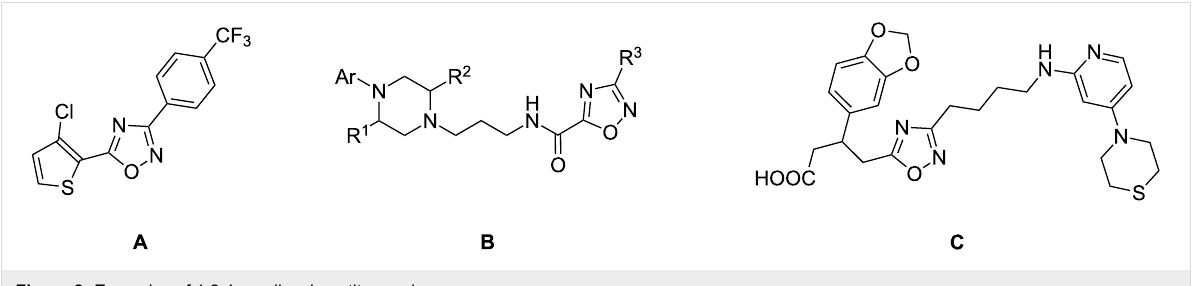
Figure 2: Examples of 1,2,4-oxadiazole antitumorals.